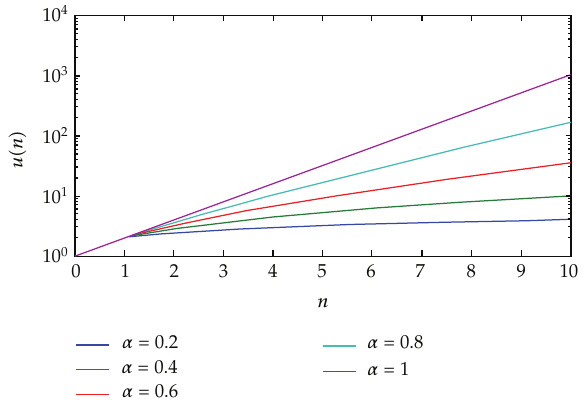
Figure 1: Numerical solution of (cid:7) 4.17 (cid:8)